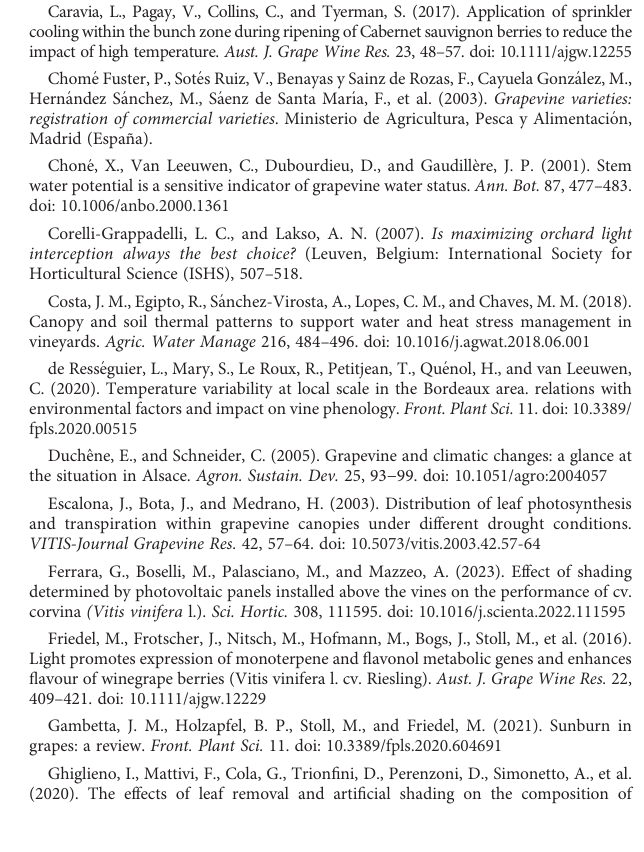
SUPPLEMENTARY FIGURE 1 Photographs of (A) the Shading and Control treatments and (B) the Double pruning treatment at the time of the second